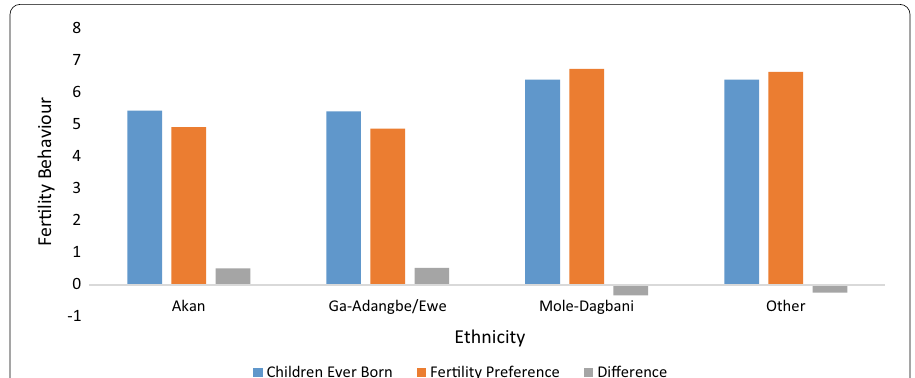
Fig. 4 Association between ethnicity and fertility behaviour in Ghana, 2014 GDHS Source: Generated from the GDHS